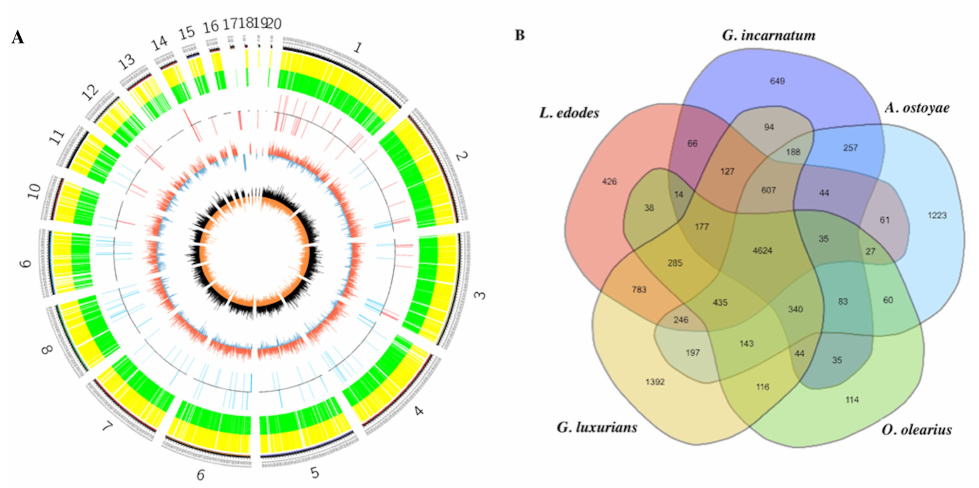
Figure 1. The Gloeostereum incarnatum genome and comparative genomics analysis. ( A ) The G. incarnatum genome. Outside to inside of concentric circles show assembly scaffold number, gene density, non-coding RNA (ncRNA), GC count and GC skew. ( B ) Unique and homologous gene families. The number of unique and shared gene families is shown in each of the diagram components and the total number of gene families for each fungus is given in